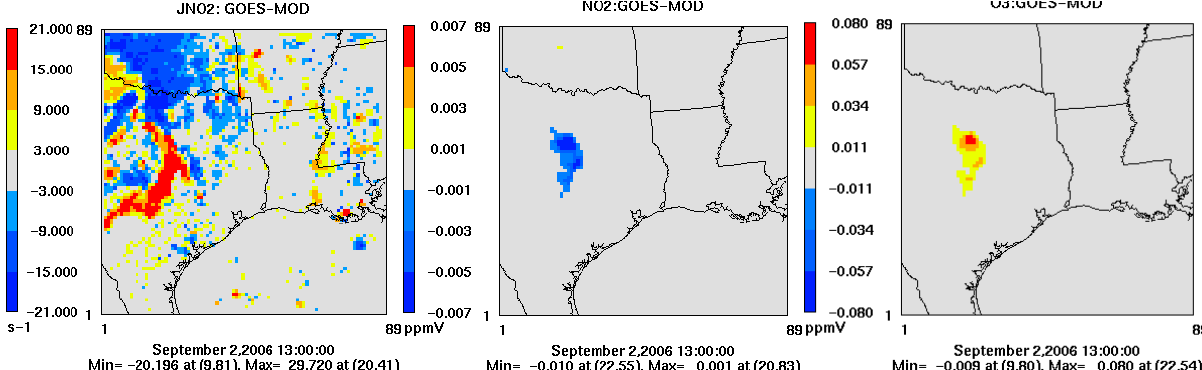
(left) in simulating NO 2 (middle) and O 3 (right) 2